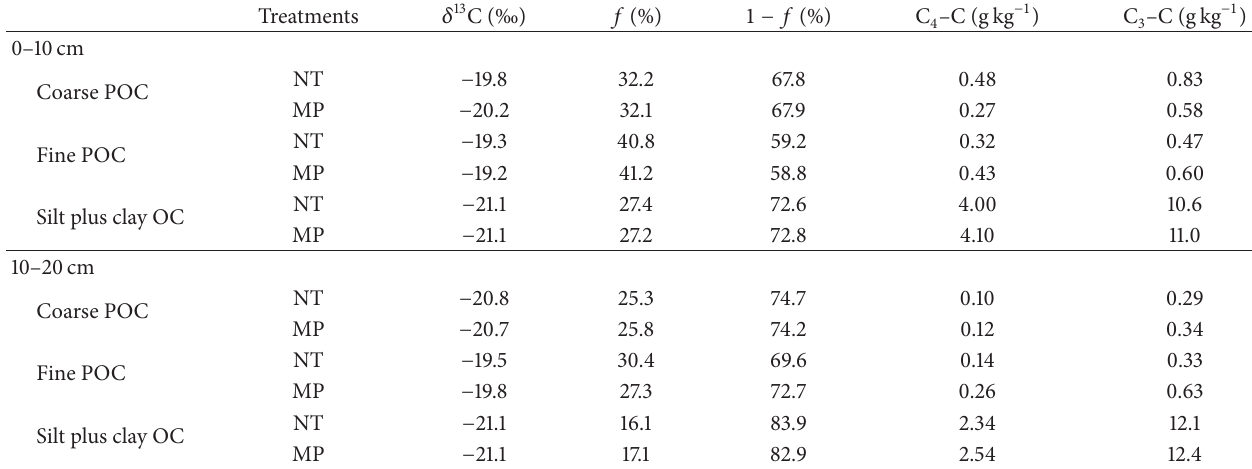
–C fractions in the plough layer of Black soil under no tillage (NT) and mouldboard plough (MP) in 4